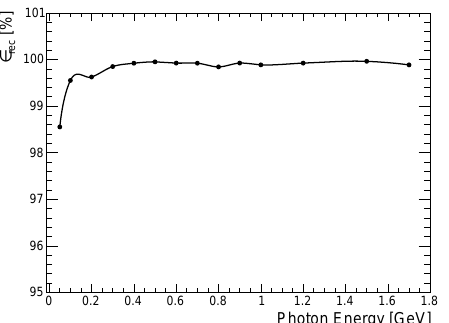
Figure 79. Reconstruction efficiency of photons in the ECAL as a function of the photon energy. Photons were generated with a particle gun in the HPgTPC volume. The efficiency is the number of events were the photon is reconstructed over the number of simulated photons at each energy. Converted photons in the TPC are ignored and account for around 10% of events at each